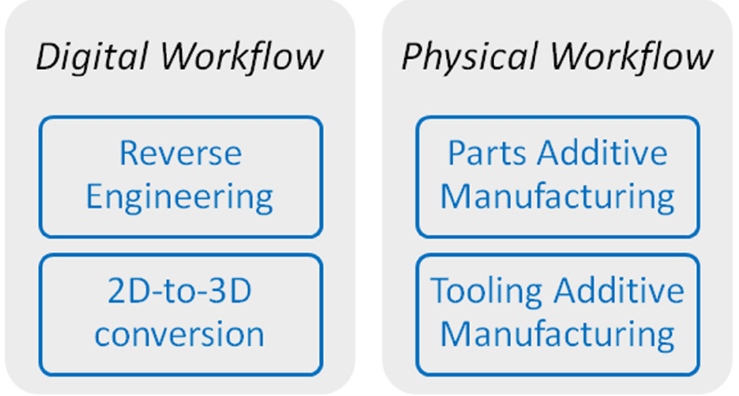
Figure 1. Key strategies of component-reconstruction workflow.